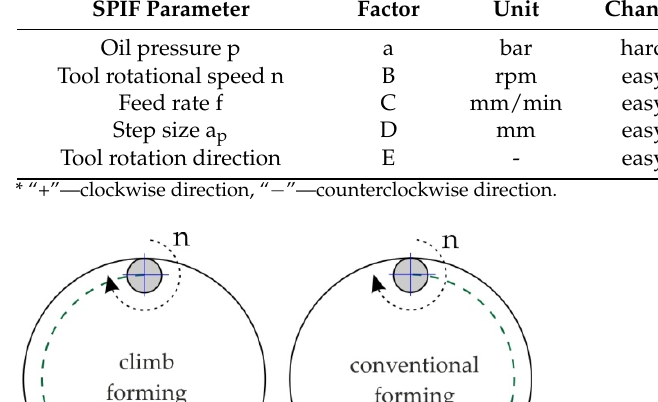
Table 2. Factors and levels used in the split-plot I-optimal design *.